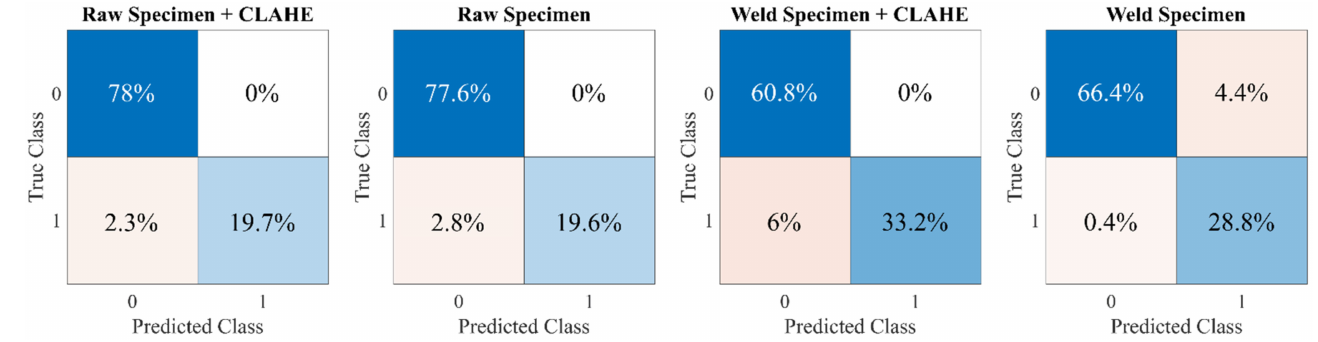
Figure 8. Confusion matrix analysis of GD-HBT algorithm on image binarization performance. Table 1. Comparison of binarization performance using eight evaluation metrics on raw and weld